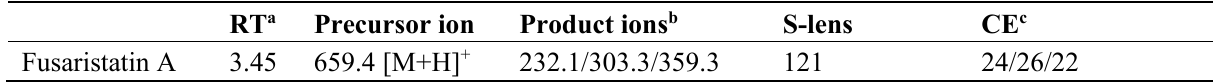
Table 1. Parameters for selected reaction monitoring (SRM) transitions for fusaristatin A.